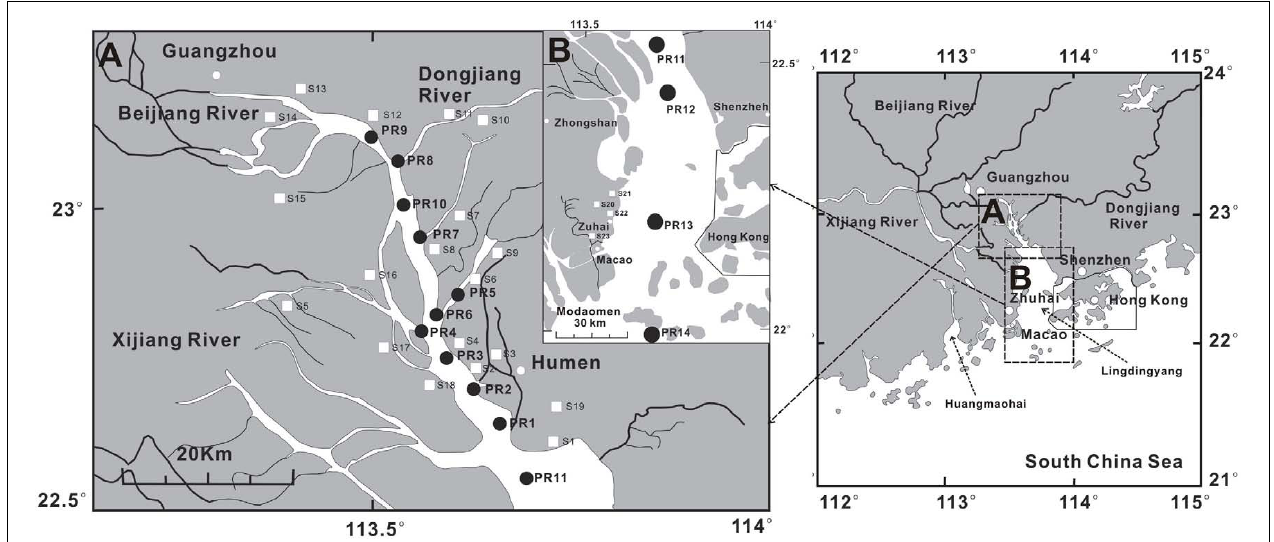
samples in the lower PR drainage basin and estuary are shown in white squares.The sediment samples were collected at the same locations at which filter samples were